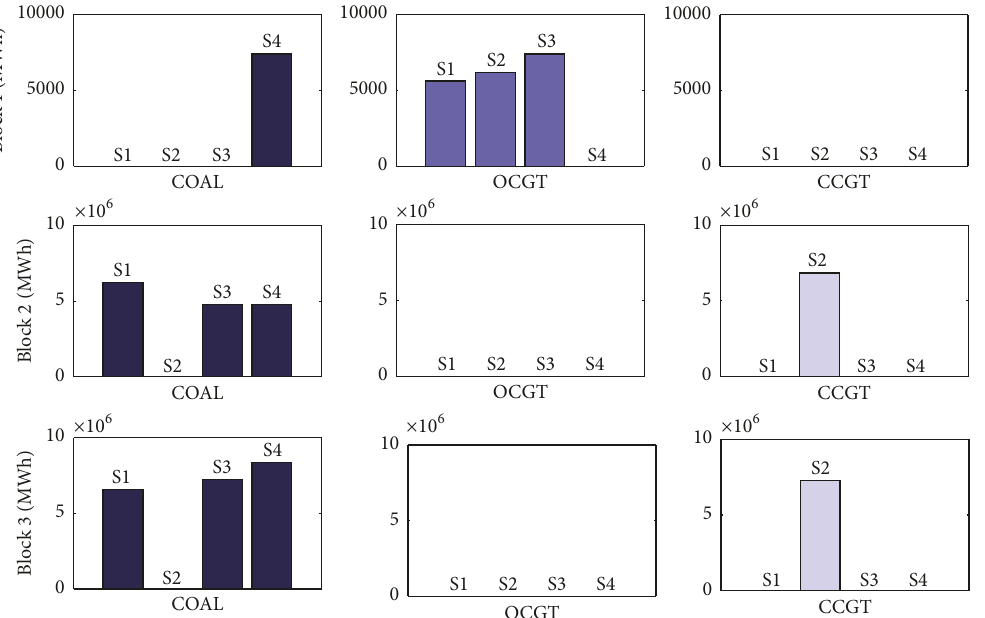
Figure 7: Ramping constrained solution use for each